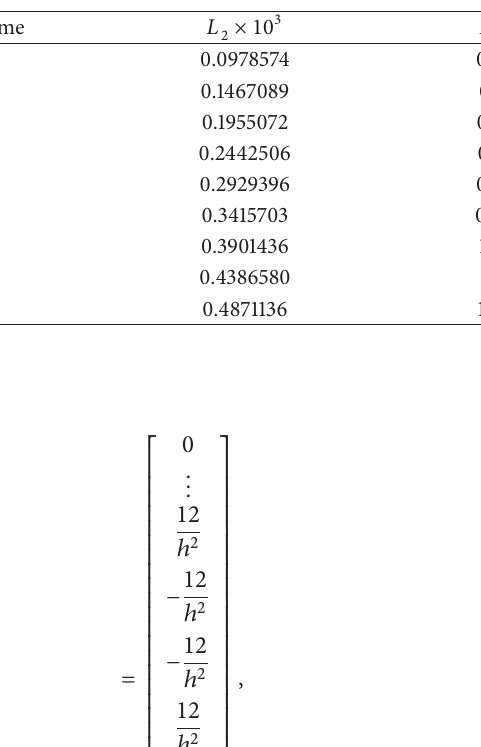
Table 3: 𝐿 2 and 𝐿 ∞ error norms for ℎ = 0.005 , Δ𝑡 = 0.01 , and V = 0.01 (SFEM).